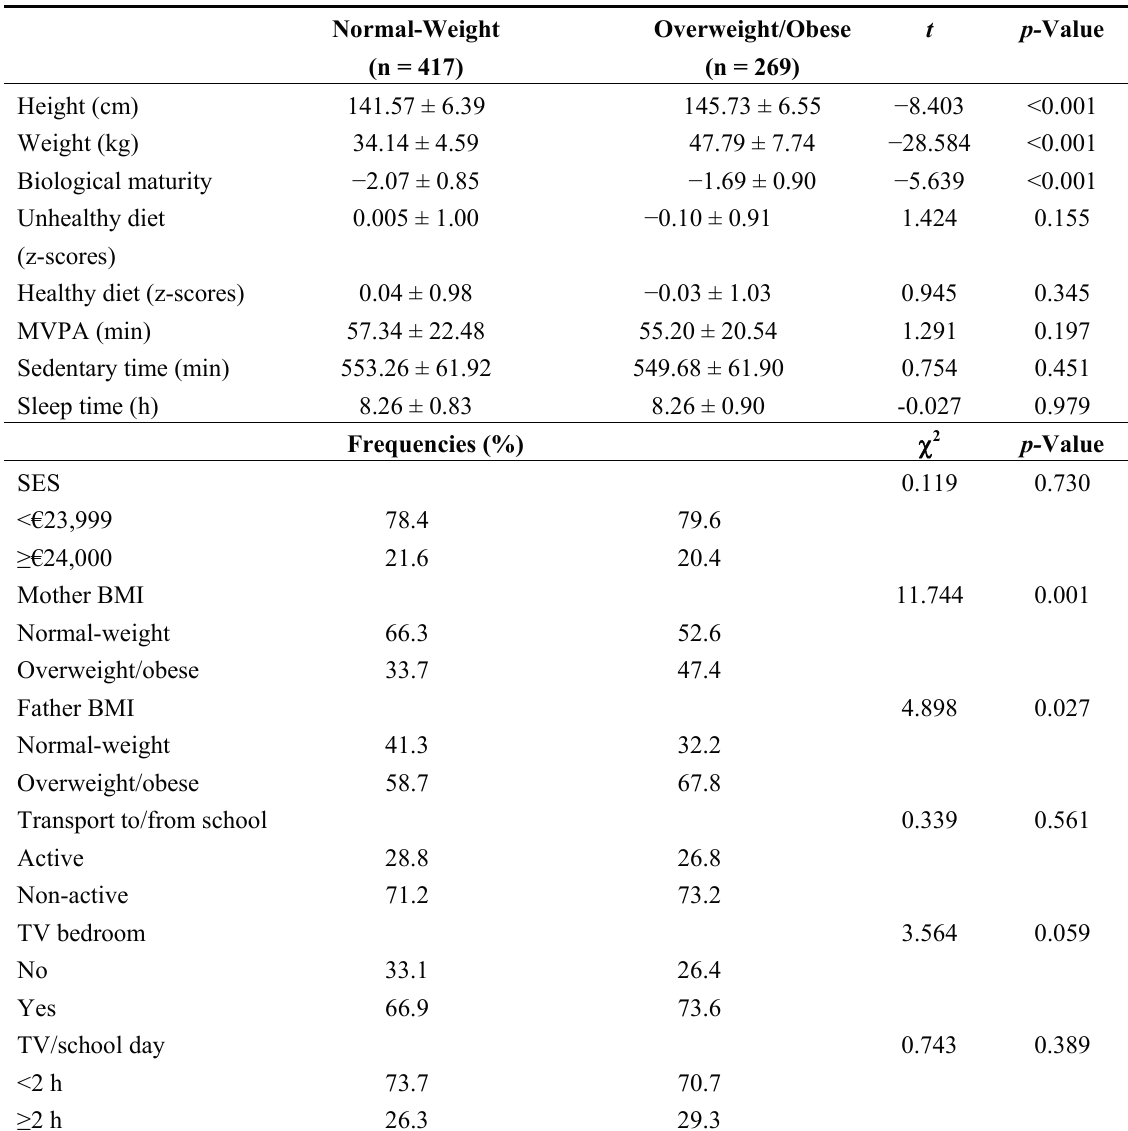
Table 2. Biological, behavioural and socio-demographic trait differences between normal-weight and overweight/obese children. Normal-Weight (n =